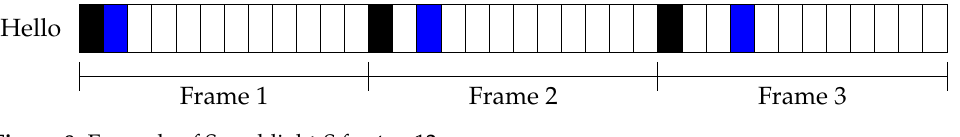
Figure 8. Example of Searchlight-S for t =